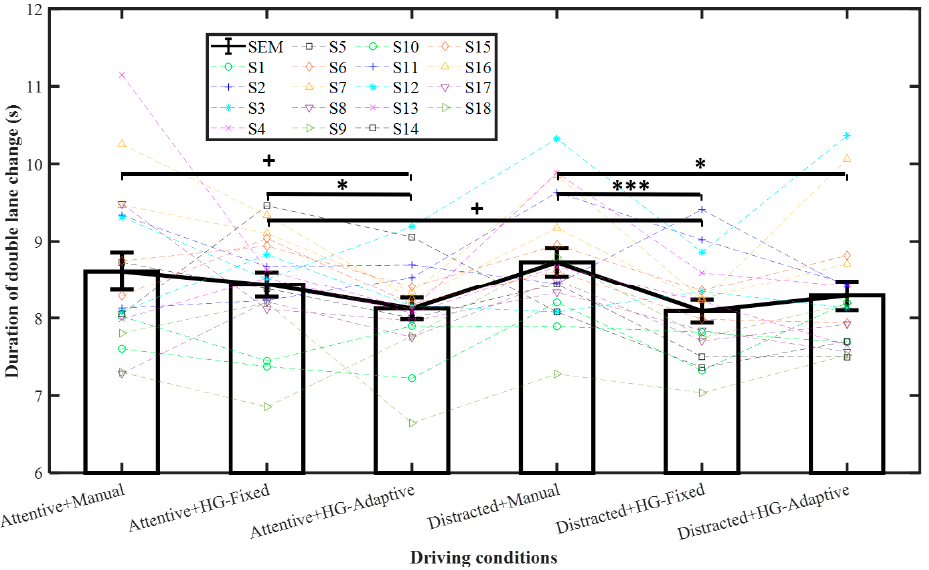
Figure 4. Double lane change duration. Mean +/ − SEM represented by error bars. + p < 0.1, * p < 0.05, and *** p < 0.001.